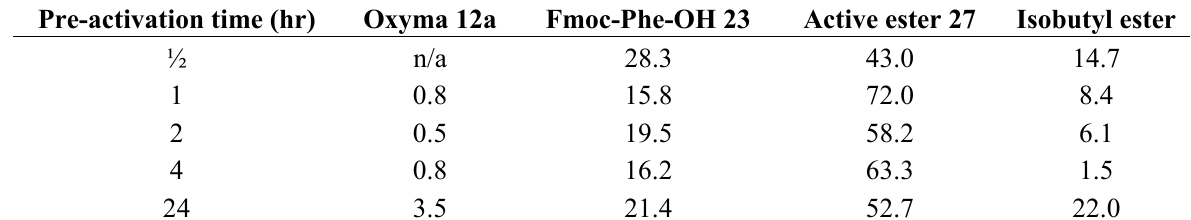
Table 8. The rate of formation of the active ester of Fmoc-Phe-OH 23 using ethyl Pre-activation time (hr)